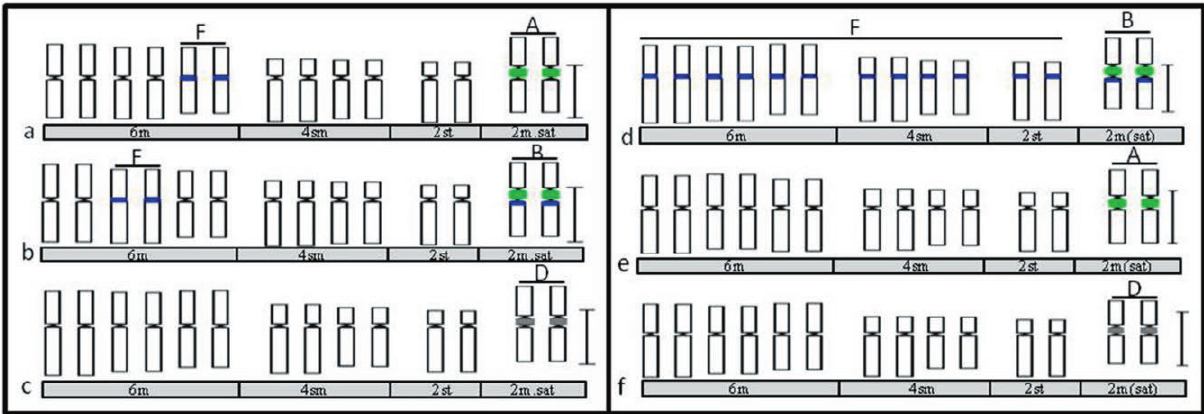
Figure 5. Fluorescent ideograms of Lens culinaris cultivars based on CMA/DAPI banding pattern: (a) Barasat Macro type, (b) PL-1406, (c) EC-70306, (d) EC -78410, (e) EC-78451-A, (f) EC-78473. CMA + , DAPI + , CMA + /DAPI + and CMA 0 bands are highlighted with green, blue, red and grey colors on the chromosomes, respectively and the types are indicated above the chromosome diagrams. Bars